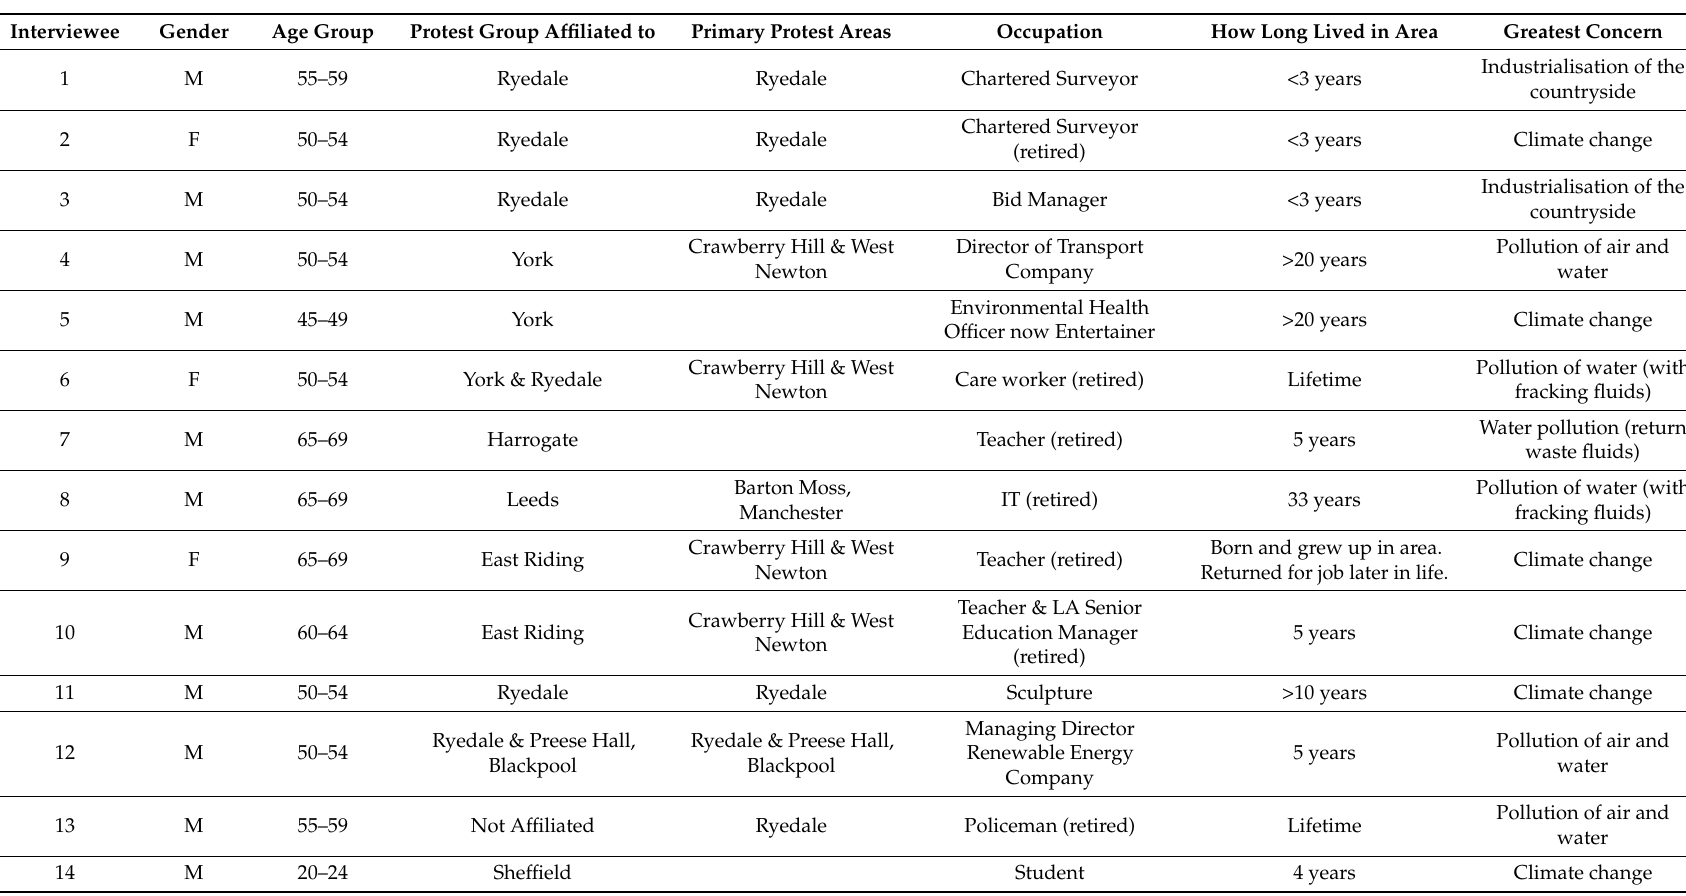
Table 1. Interviewees’ demographic information, protest group allegiance, and greatest concern about fracking as stated at the time of